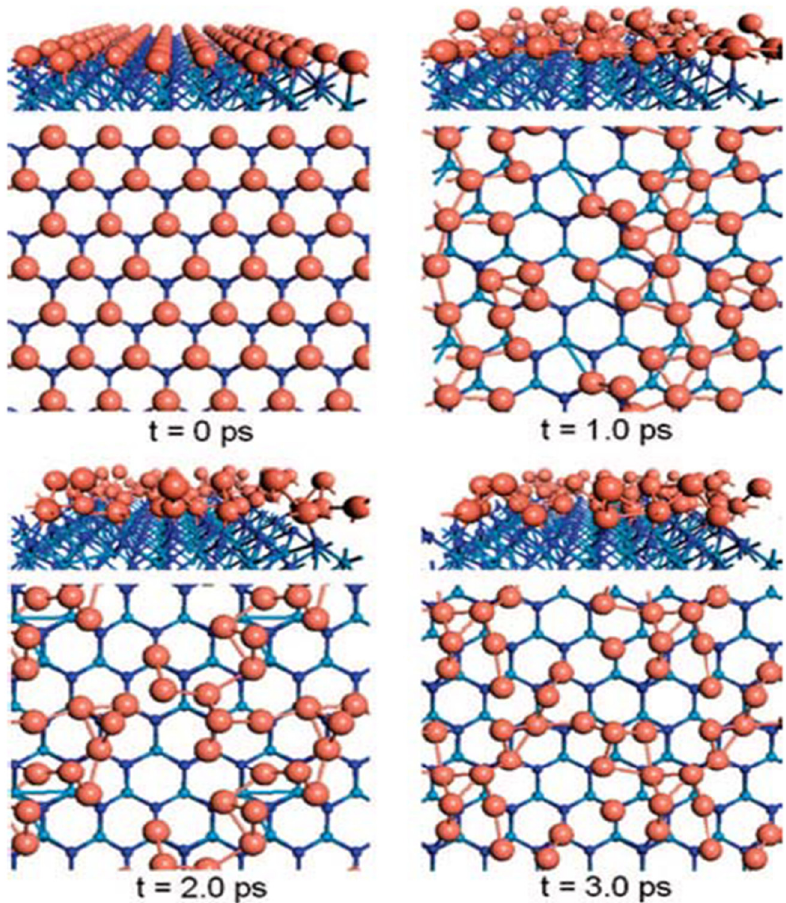
Figure 18: MD trajectory [ 189 ] . The copper monolayer was initially well aligned and in proportion with the substrate. Through surface di ff usion, copper atoms were then rapidly disassembled and moved away from their equilibrium locations when molecular dynamics was run.